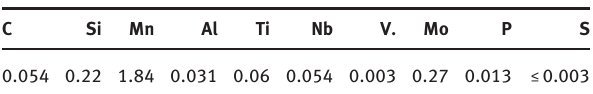
Table 2: Welding